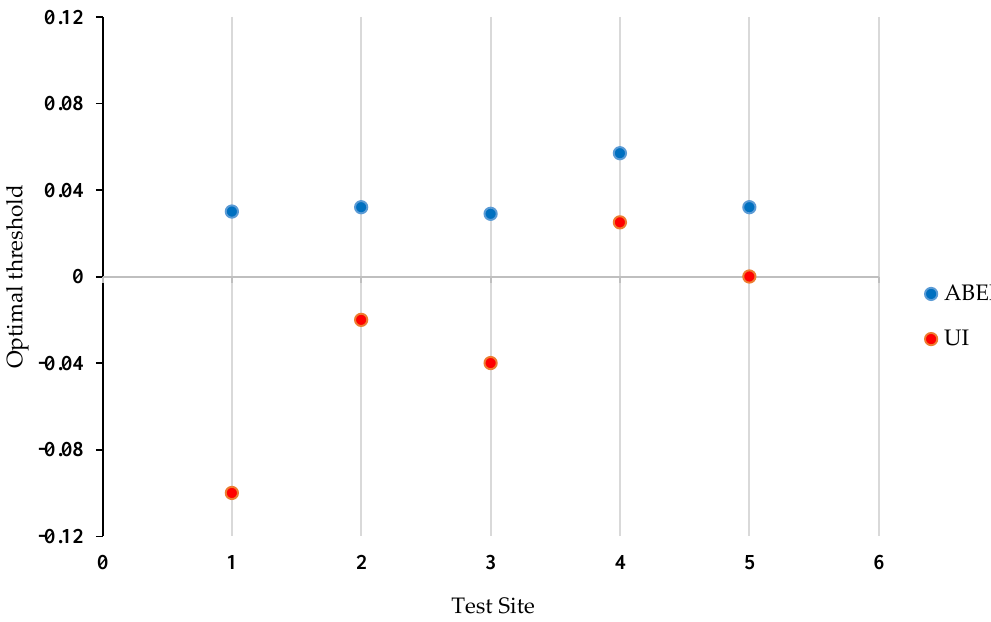
Figure 5. Optimal thresholds for the five test sites.